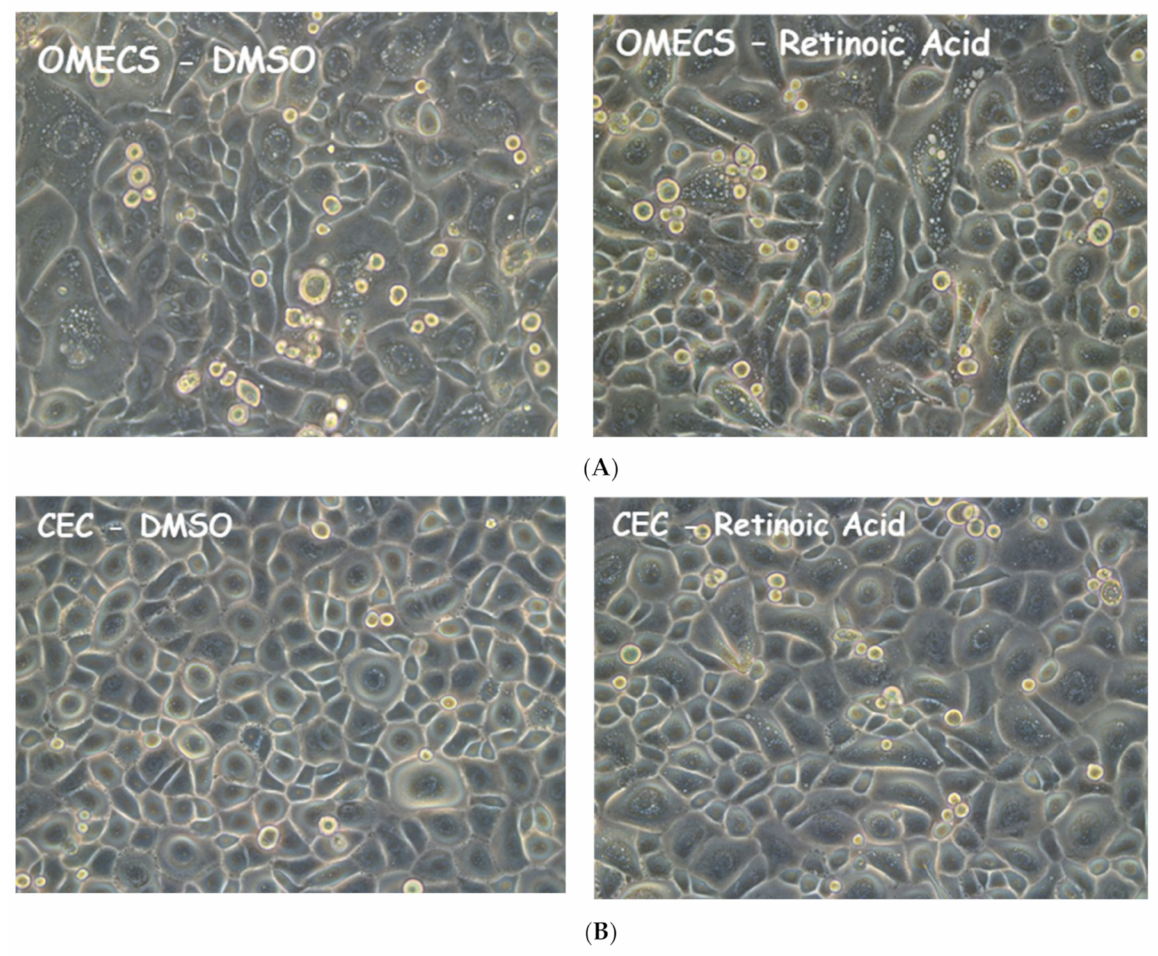
Figure 4. Cell culture of human oral mucosal and corneal epithelial cells ( A , B respectively, OMECS and CEC). Cells were expanded and then treated with retinoic acid when 100% confluent. RA treatment was done for 24 h. Cells were then harvest and processed for biochemical analysis. The included images are representation of a large sample size. Magnification is 20 ×